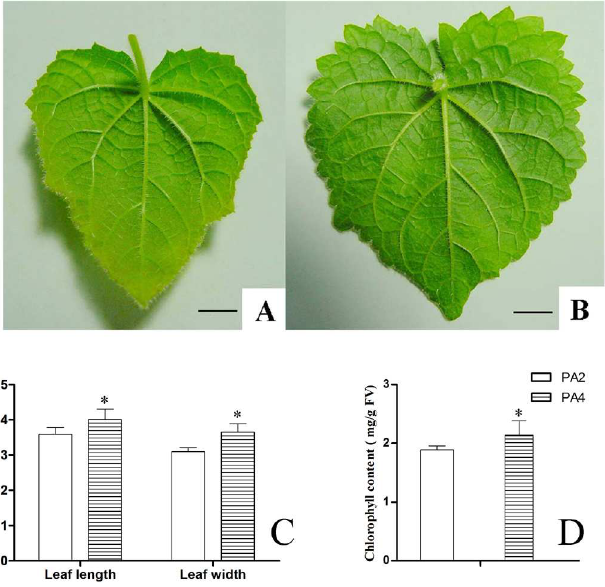
Fig 1. Comparisons of leaves between PA2 and PA4. (A) Leaves of PA2 (B) Leaves of PA4 (C) Length and width of Leaves (D) Chlorophyll content of Leaves. Bar = 1cm. Error bars represent the standard error of the mean. * : Statistically significantdifferences betweenPA2 and PA4 ( P <